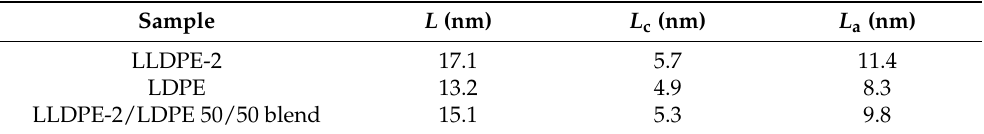
Figure 10. The one-dimension correlation functions of the neat LLDPE-2, the neat LDPE, and the LLDPE-2/LDPE blend. Table 7. Data of the long spacing ( L ), crystalline phase thickness ( L c ), and amorphous phase thickness ( L a ) obtained from the one-dimension correlation function.